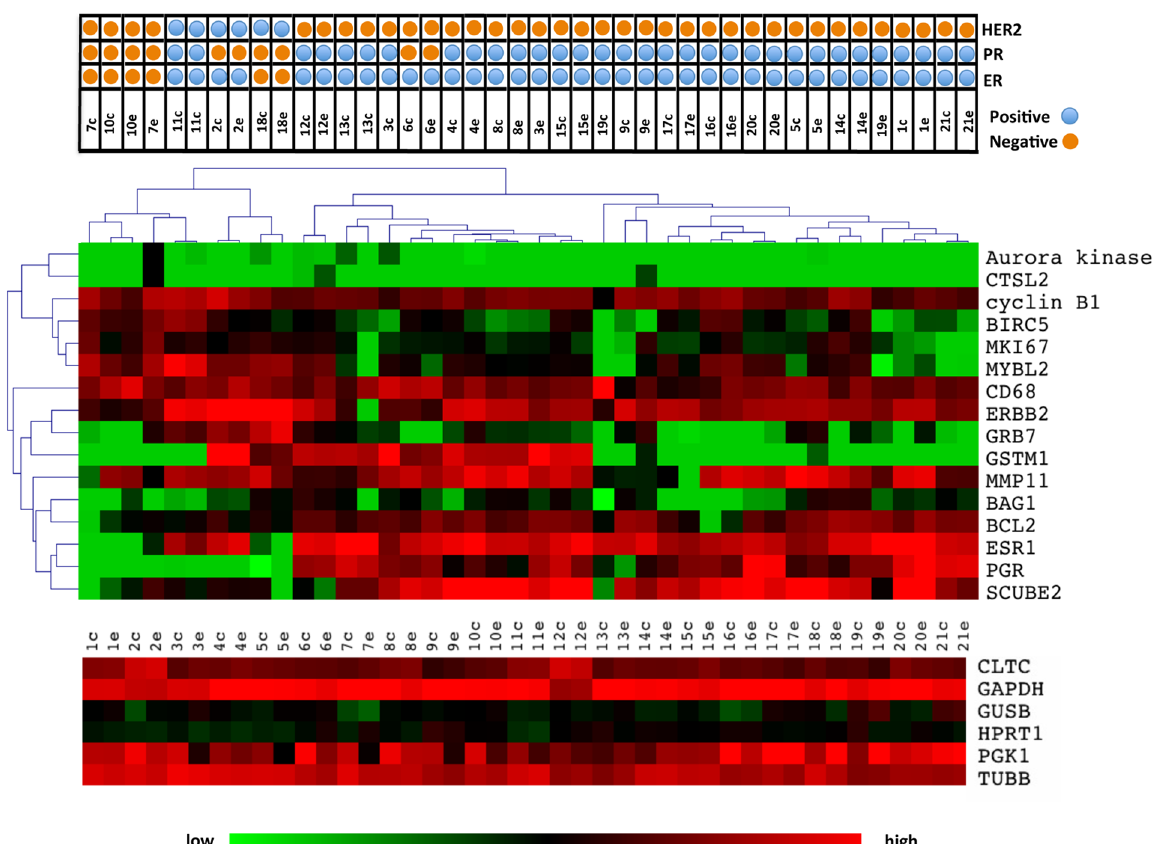
Figure 3. Heatmap of unsupervised clustering of the CNB and EBS using the Oncotype Dx genes. Unsupervised clustering heatmap of all samples using the Oncotype Dx genes only. 18 of the 21 paired biopsies co-aggregated in the first level dendrogram. Lower heatmap shows the Nanostring expression levels of the control housekeeping genes.